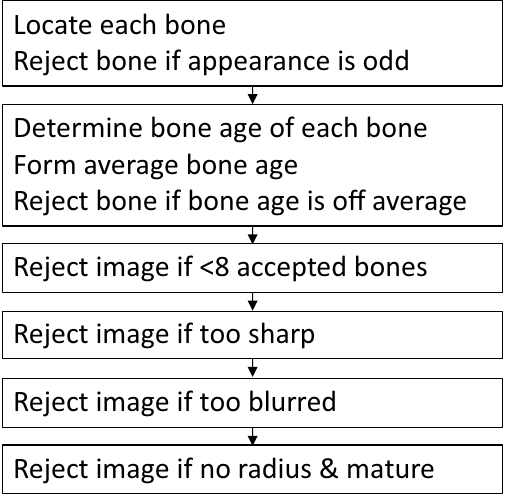
Figure 1. Flowchart of the software architecture. The architecture is dominated by the six steps of the selfvalidation. The first two steps validate individual bone contributions, while the last four validate the entire